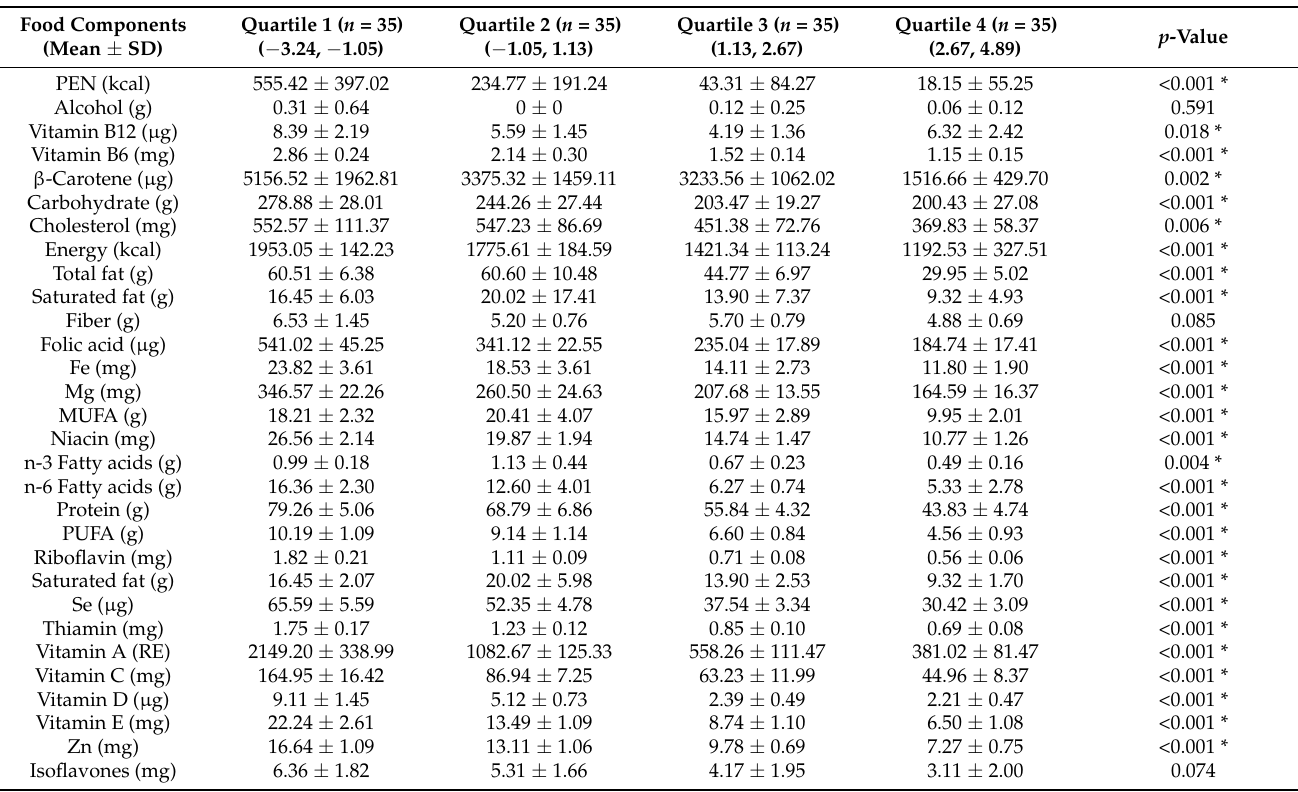
Table 2. Dietary intakes of CD patients across quartiles of the DII.